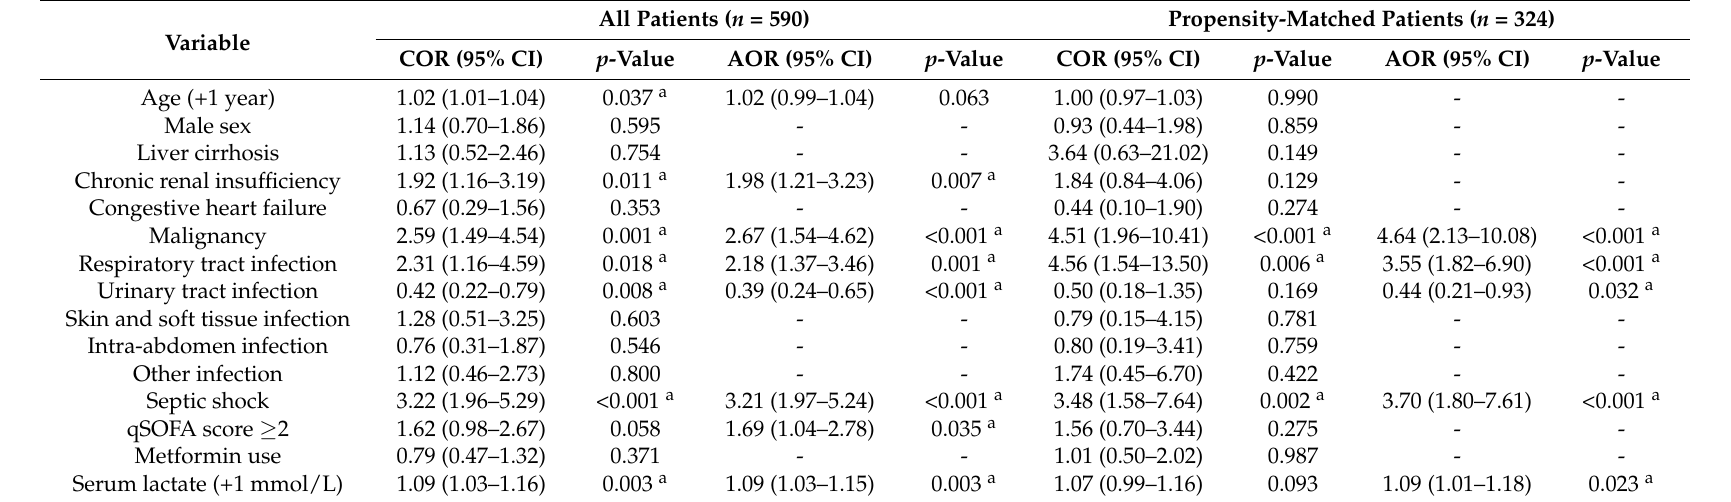
Table 2. Multiple logistic regression analyses for variables associated with 28-day